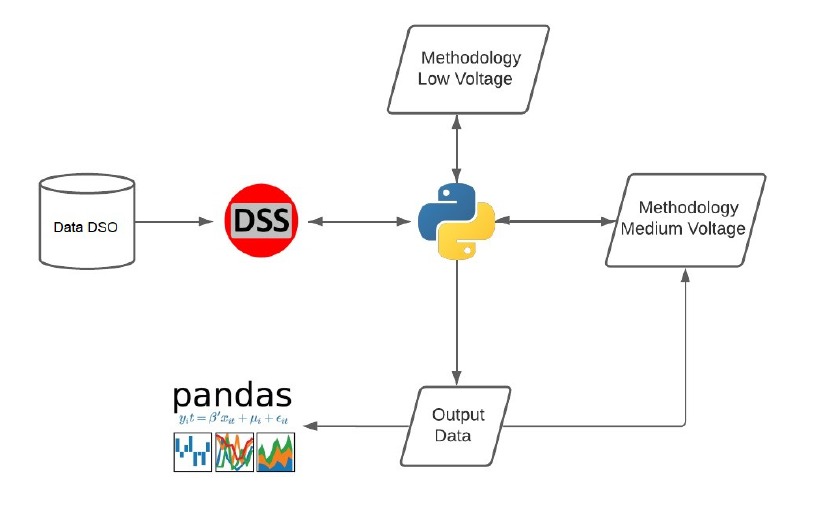
Figure 1. Flowchart of the proposed